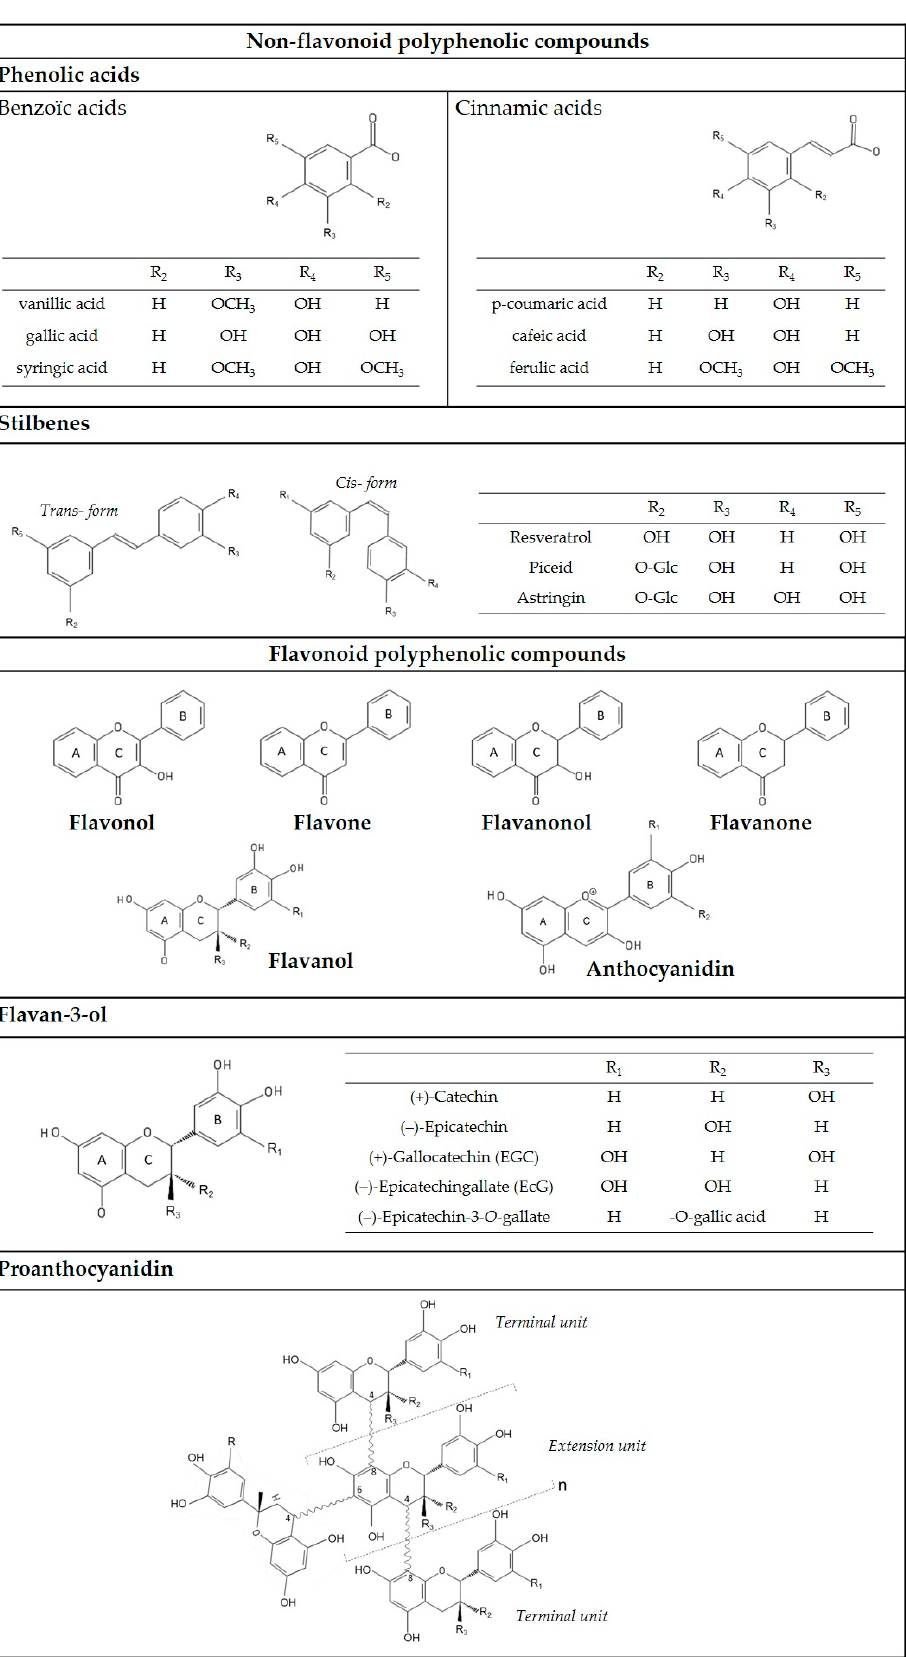
Figure 3. Non-flavonoid and flavonoid polyphenolic compound of grapes and wine.